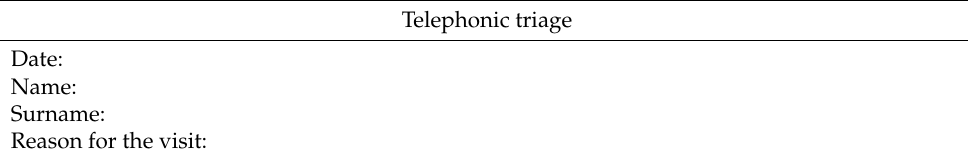
Table 2. Pre-check telephonic triage for COVID-19 management in dental